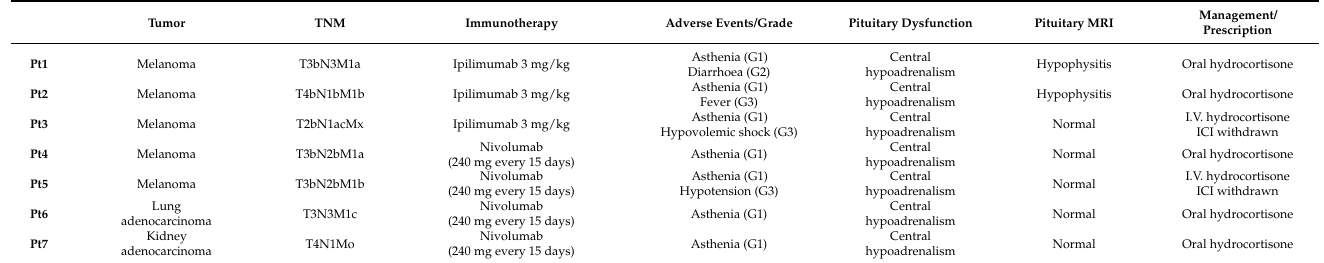
Table 1. Clinical aspects of study cohort, endocrine adverse events during ICI, and clinical management.